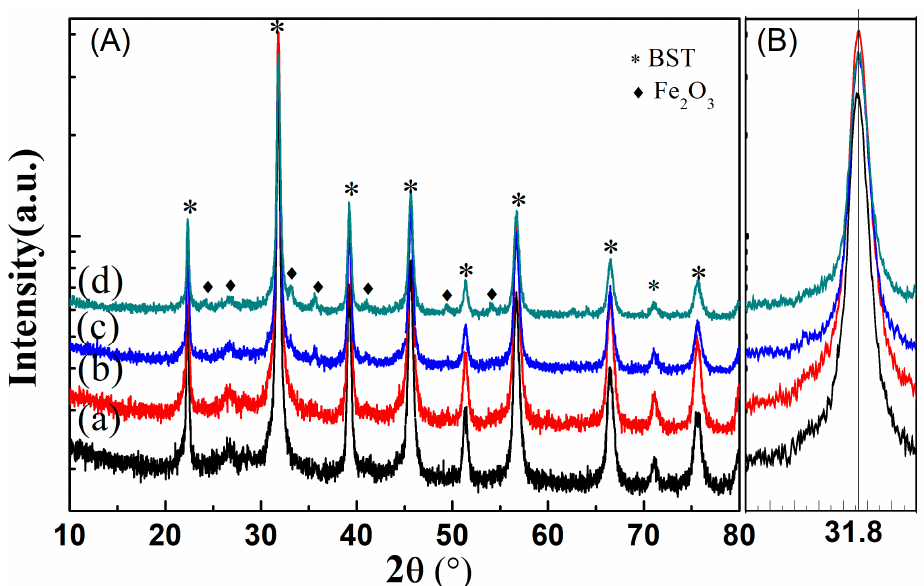
Figure 4. ( A ) XRD patterns of BST@Fe 2 O 3 composite powders with different Fe 2 O 3 coating amounts ( a ) 2.5 wt%, ( b ) 5 wt%, ( c ) 7.5 wt% and ( d ) 10 wt% calcined at 600 °C for 2 h. ( B ) the locally magnified (110) diffraction peaks.